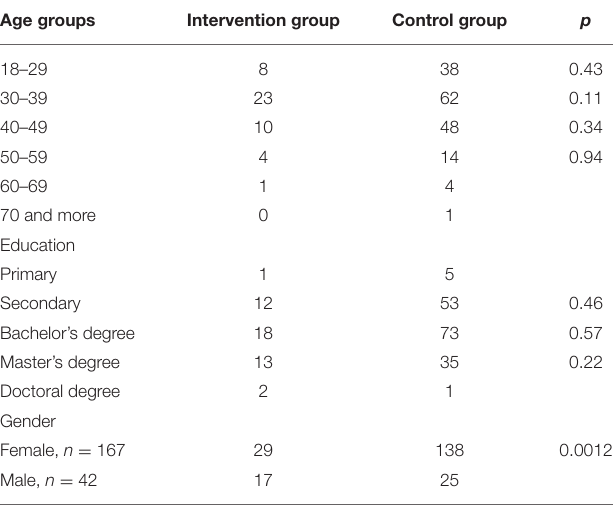
TABLE 4 | Sample demographics according to the first